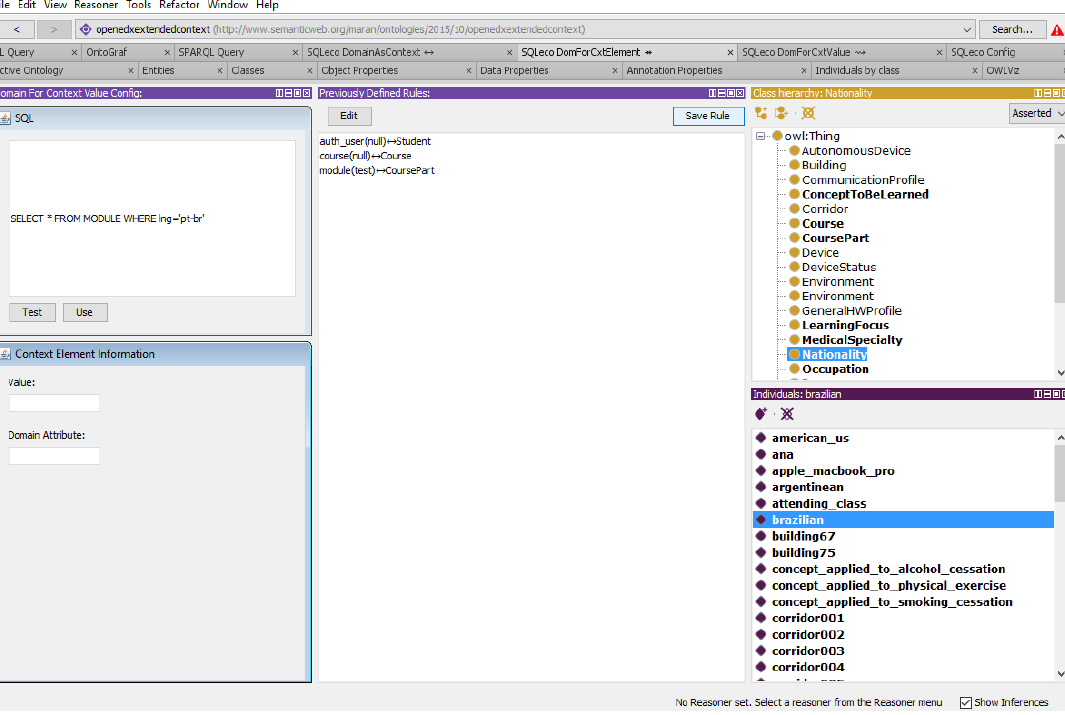
Figure 11. An interface to create linking rules in SQL-eCO ( SQL-extension based on Context-Awareness )